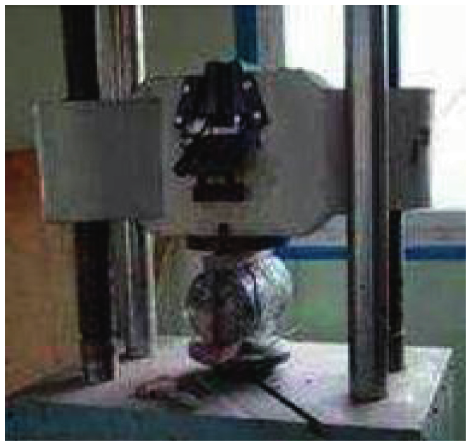
Figure 4: Cleavage